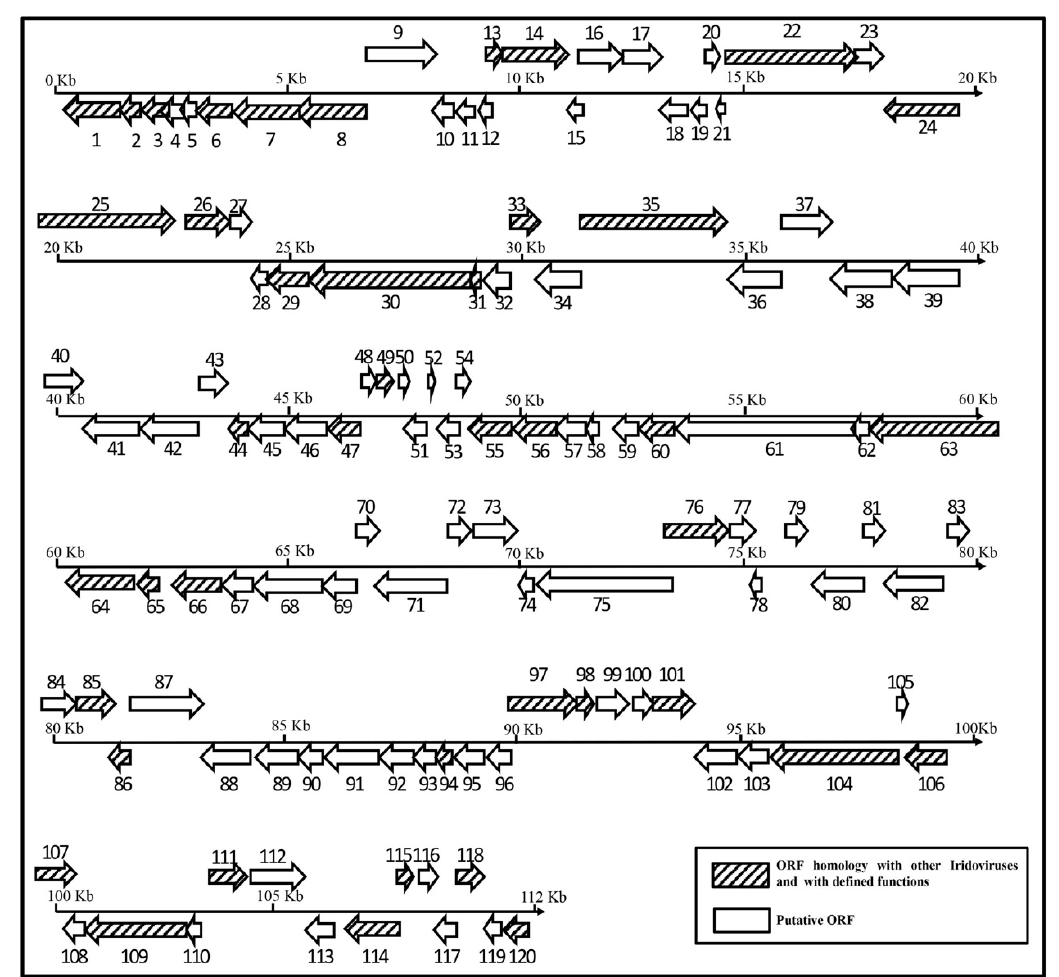
Figure 2. Organization of the LYCIV-ZS-2020 genome. Predicted ORFs are numbered from left to right and represented by arrows indicating their approximate size, location, and orientation based on the positions of methionine start and stop codons. Arrows with diagonals represent the ORFs homology with other iridoviruses and defined functions, and the white arrows represent those with unknown functions.